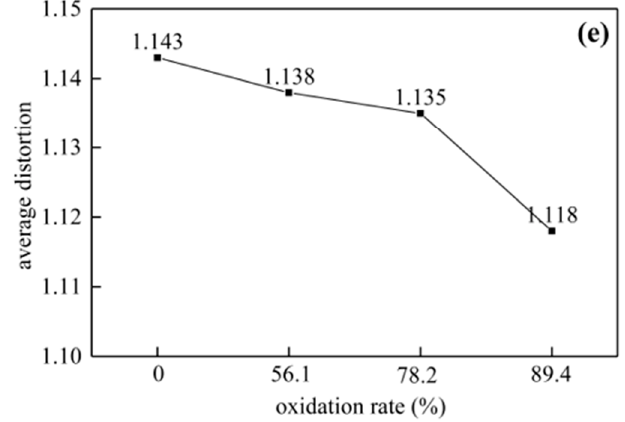
Figure 7. Carbon layer distortion distribution and average tortuosity for different soot oxidation rates: ( a ) 0%, ( b ) 56.1%, ( c ) 71.2%, ( d ) 89.4%, ( e ) average distortion.